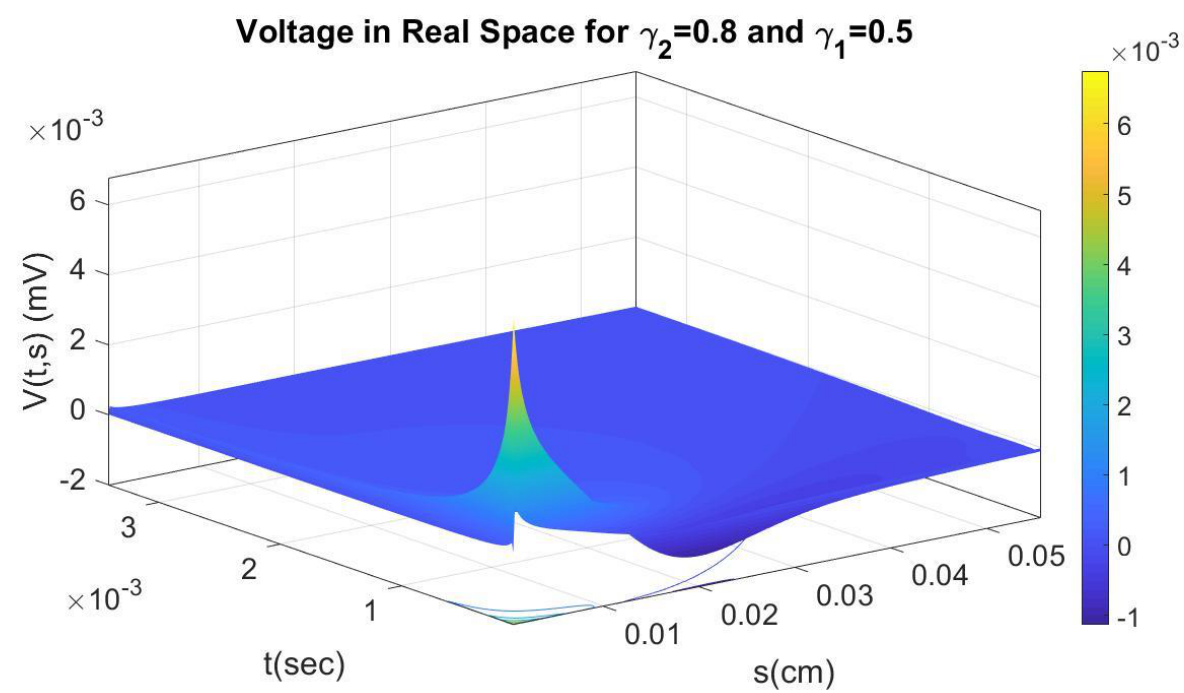
Figure 7. The voltage V(t,s) in real space as a function of time and arc length s, for fractional orders γ 2 = 0.8 and γ 1 = 0.7.